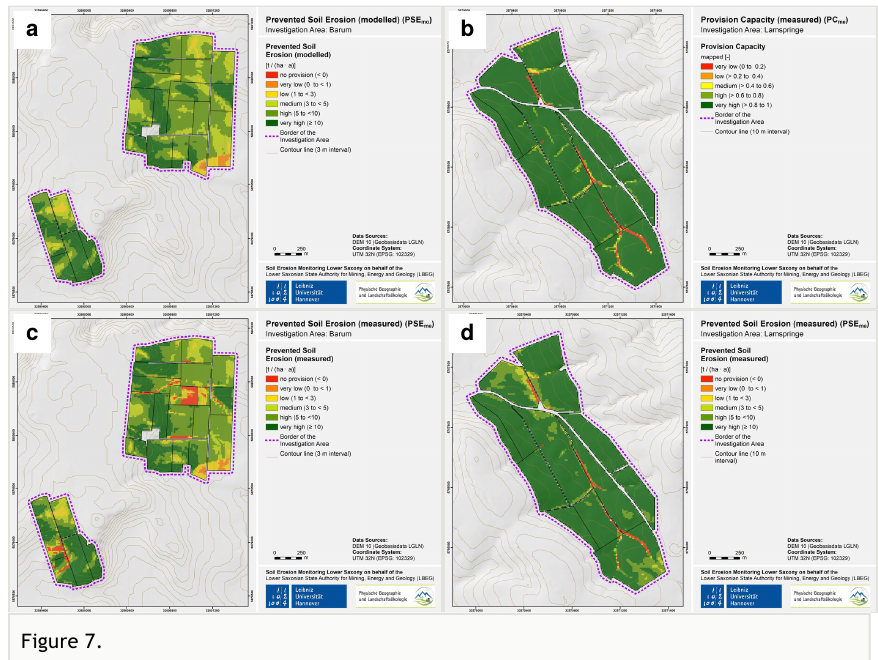
Figure 7. Maps of prevented soil erosion (modelled) (PSE ) and prevented soil erosion (measured) (PSE ) for two exemplary investigation areas. a : Prevented soil erosion (modelled) (PSE ) in the investigation area Barum (northern region). b : Prevented soil erosion (modelled) (PSE ) in the investigation area Lamspringe (southern region). c : Prevented soil erosion (measured) (PSE ) in the investigation area Barum (northern region). d : Prevented soil erosion (measured) (PSE ) in the investigation area Lamspringe (southern The mean PSE for the whole investigation area was 1.14 times higher for the measurement approach (PSE : 17.02 t ha a ) than for the modelling approach (PSE : 14.99 t ha a ). On the regional level, the prevented soil loss was smallest in the north. This result contradicts the fi nding that the highest maximum values for both approaches were also located in the northern region (Table 6). The PSE values lower than 3 t ha a (classes no provision, very low and low ) cover 4 %, the class very high ( ≥ 10 t ha a ) covers 69% of the investigation area (see Fig. 8). In the modelling approach (PSE ), areas with prevented soil loss lower than 3 t ha a cover with 2.2% an even lower proportion of the investigation area and also the class very high ( ≥ 10 t ha a ) was, with a proportion of 65.2%, less common than in the measurement approach.